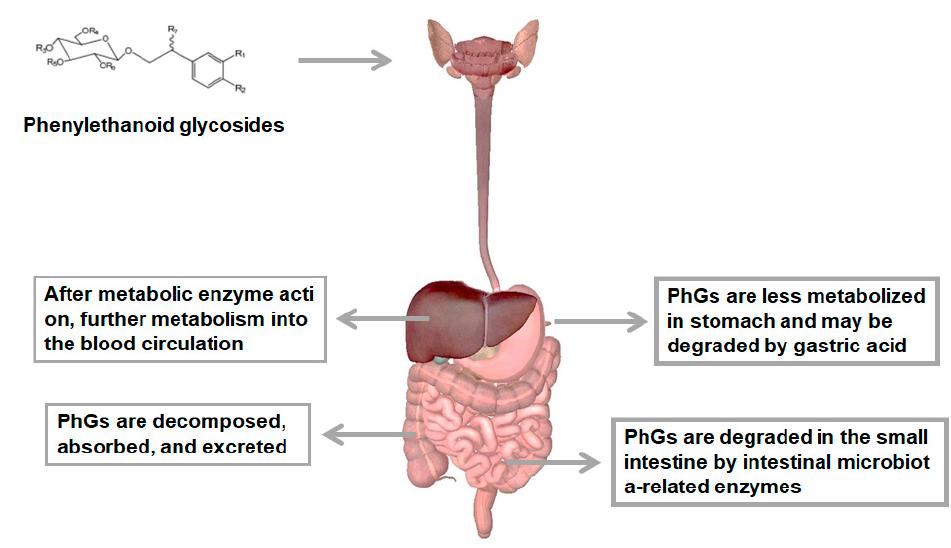
Figure 2. The absorption and metabolism of PhGs in vivo .